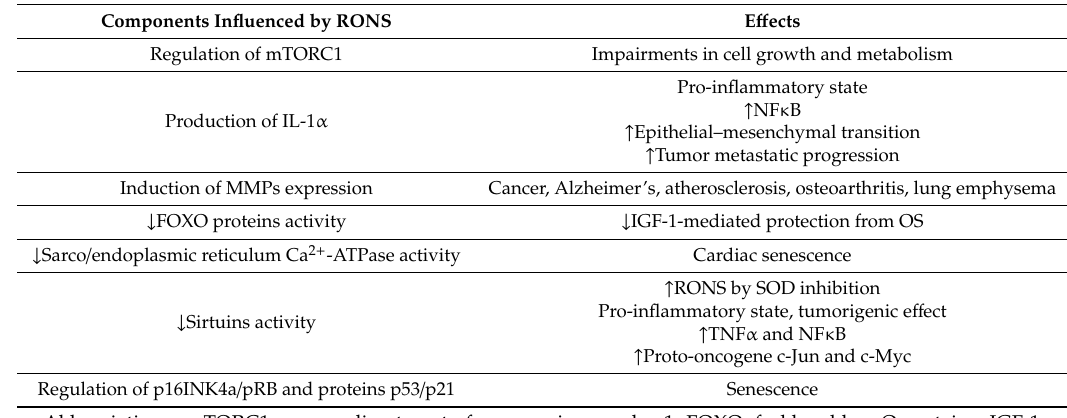
Table 1. Components influenced by reactive oxygen and nitrogen species (RONS) and effects provoked [50]. ↑ Means increase; ↓ means decrease/reduction.